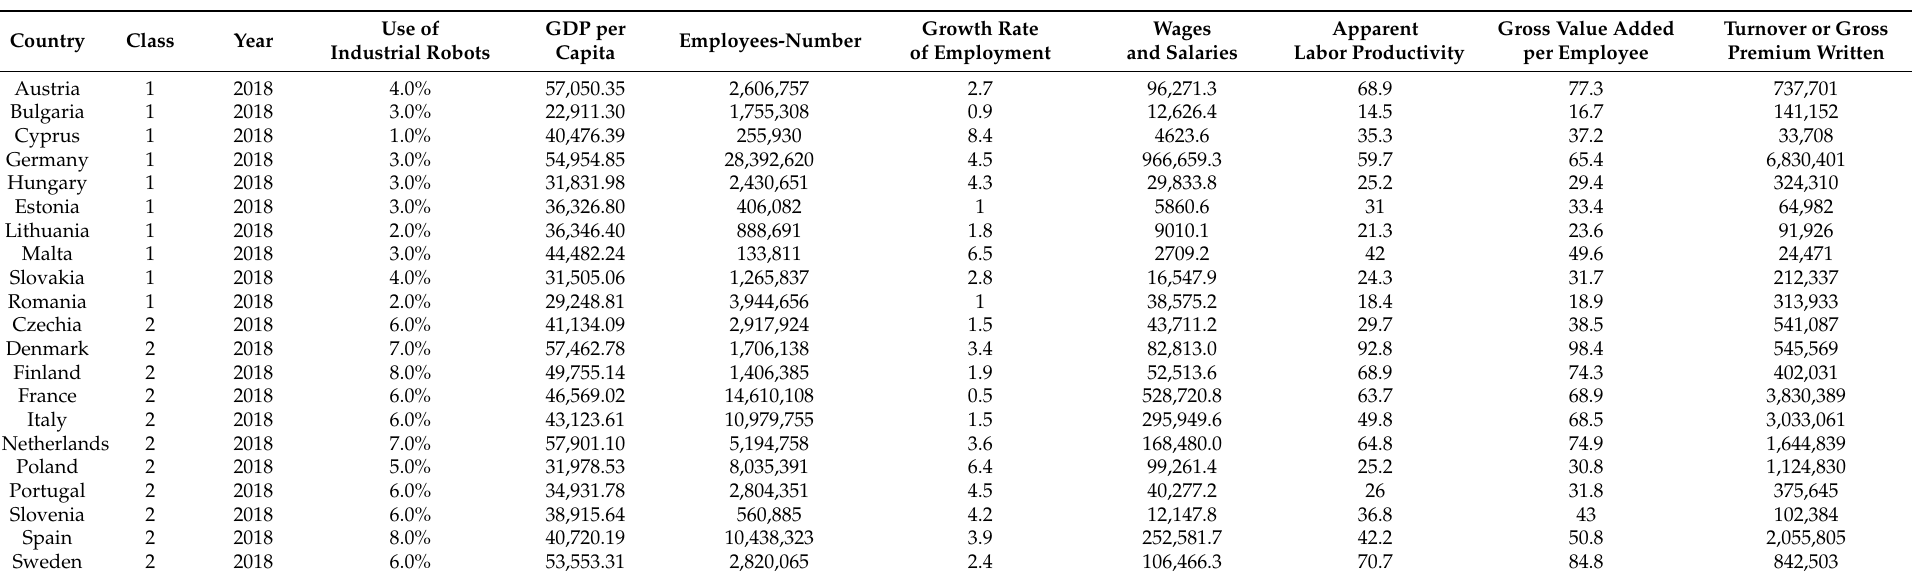
Table 1. Annual enterprise statistics for special aggregates of activities NACE Rev.2. bn_s95_x_k. Source: Author’s contribution based on data retrieved from Eurostat. Annual enterprise statistics for special aggregates of activities. https://appsso.eurostat.ec.europa.eu/nui/show.do?dataset=sbs_na_sca_r2&lang=en, accessed on 9 January